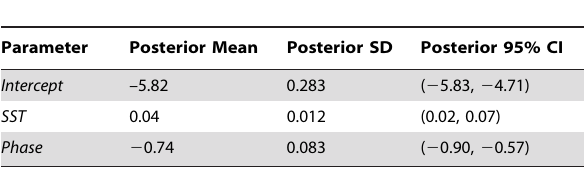
Table 1. Population level posterior means, standard deviations, and 95% credible intervals from a fit of the hierarchical